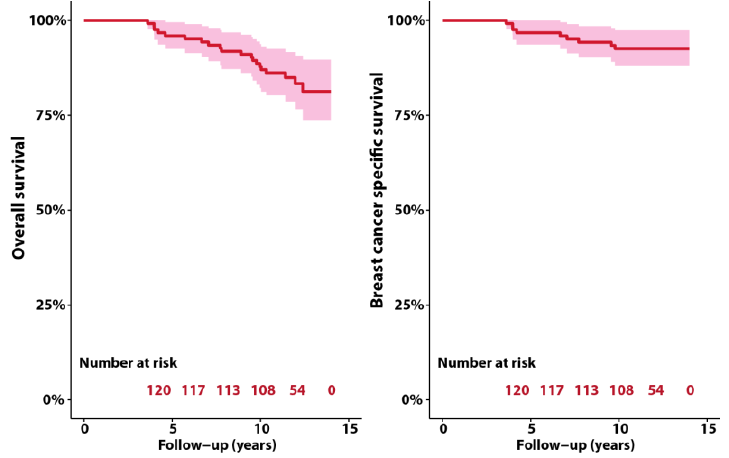
Figure 4. Overall survival and breast cancer specific survival of the study population.